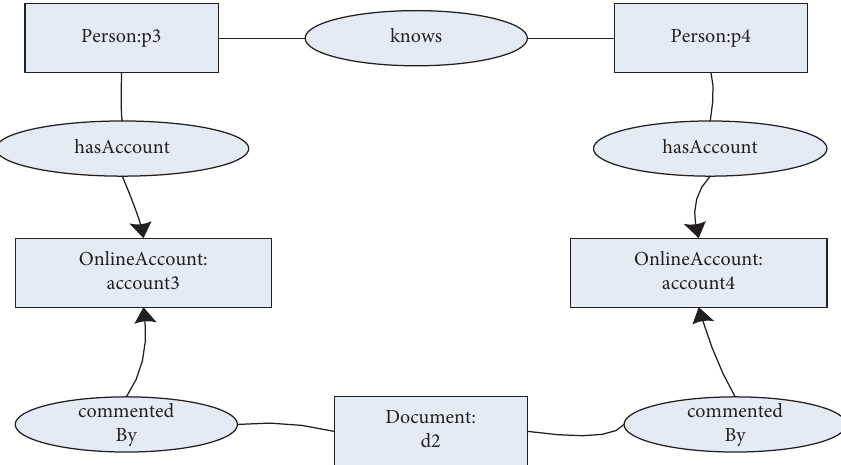
Figure 5: Integration of “knows” relationship between